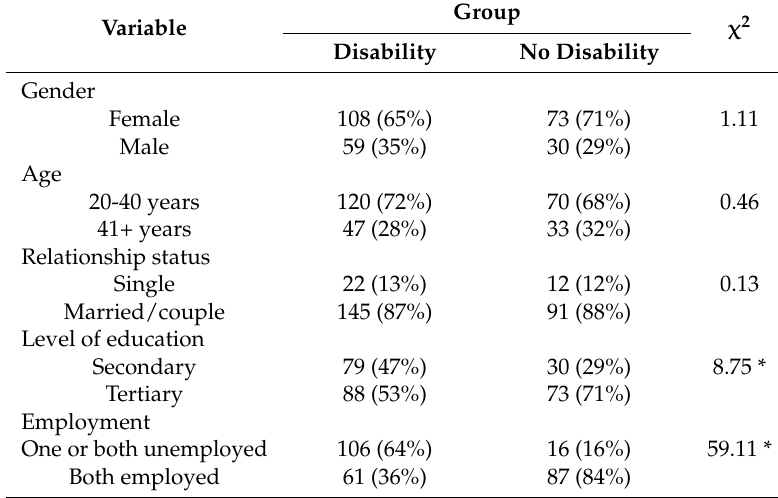
Table 1. Comparison of parent demographic variables for the two groups of children with developmental disabilities ( n = 167) and children with typical development ( n =